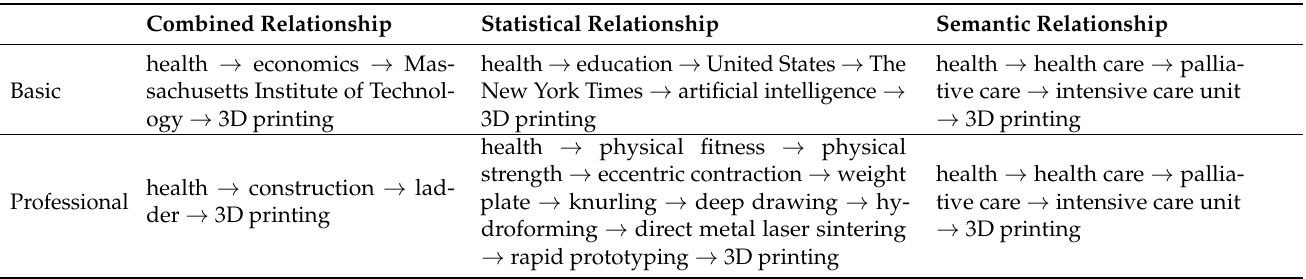
Table 5. The high-correlated knowledge associations between “health” and “3d printing” with three different